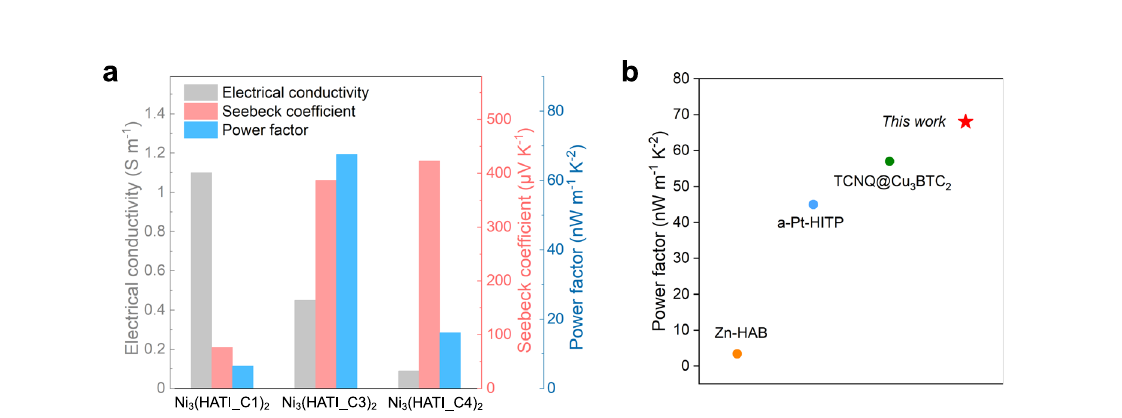
Fig. 4 | Seebeck coef fi cientsandthermoelectricpropertiesof2D c-MOFs.a The thermoelectric properties (electrical conductivity, Seebeck coef fi cient, and power